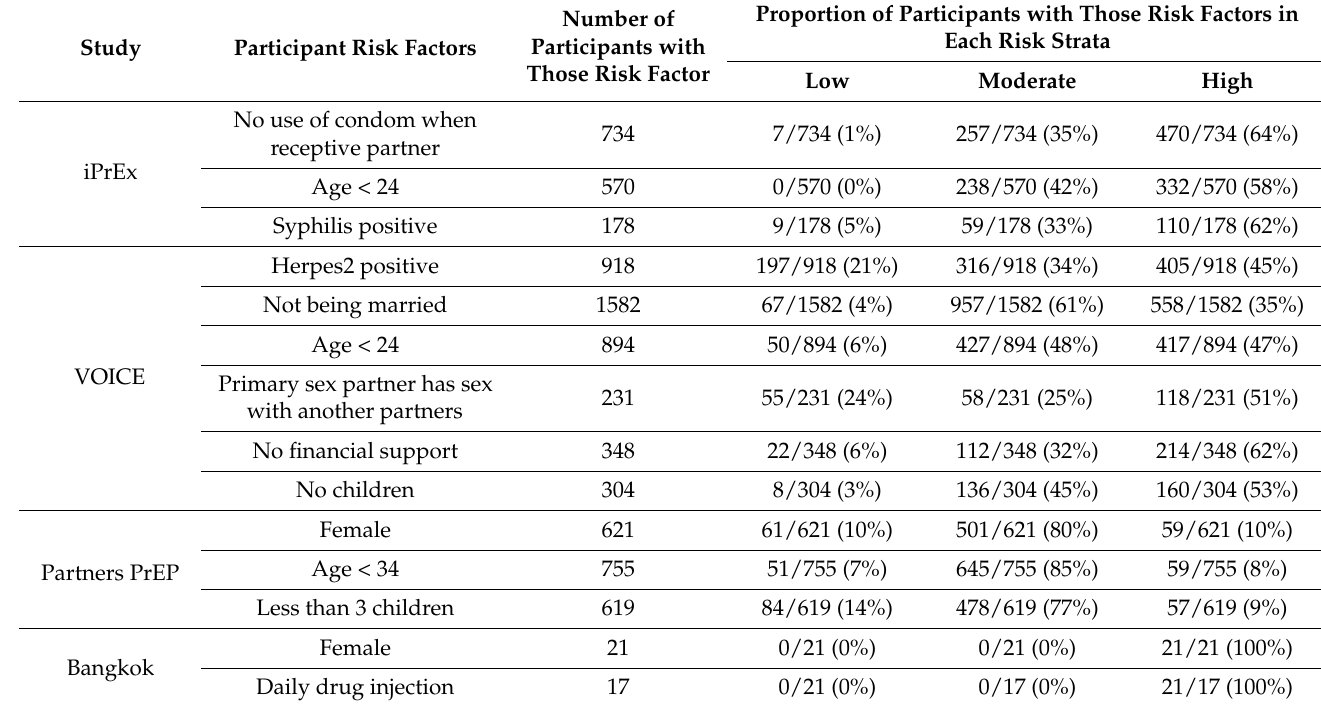
Table 3. Distribution of identified risk factors among low, medium, and high-risk